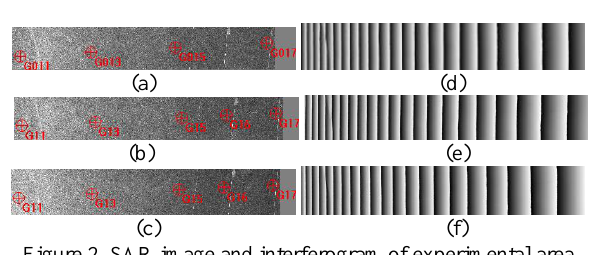
Figure 1. Schematic Diagram of Airlines